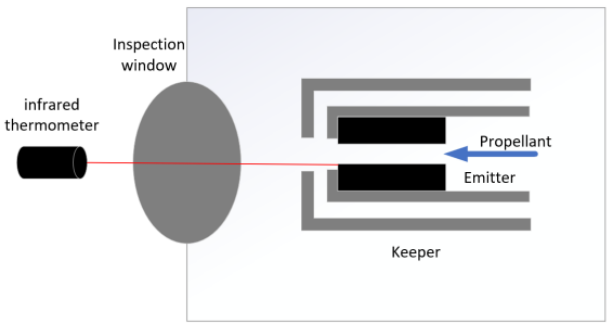
Figure 6. Schematic of the temperature measurement of the electride insert. Table 3. Comparison of measured and calculated values of the insert operating temperature.